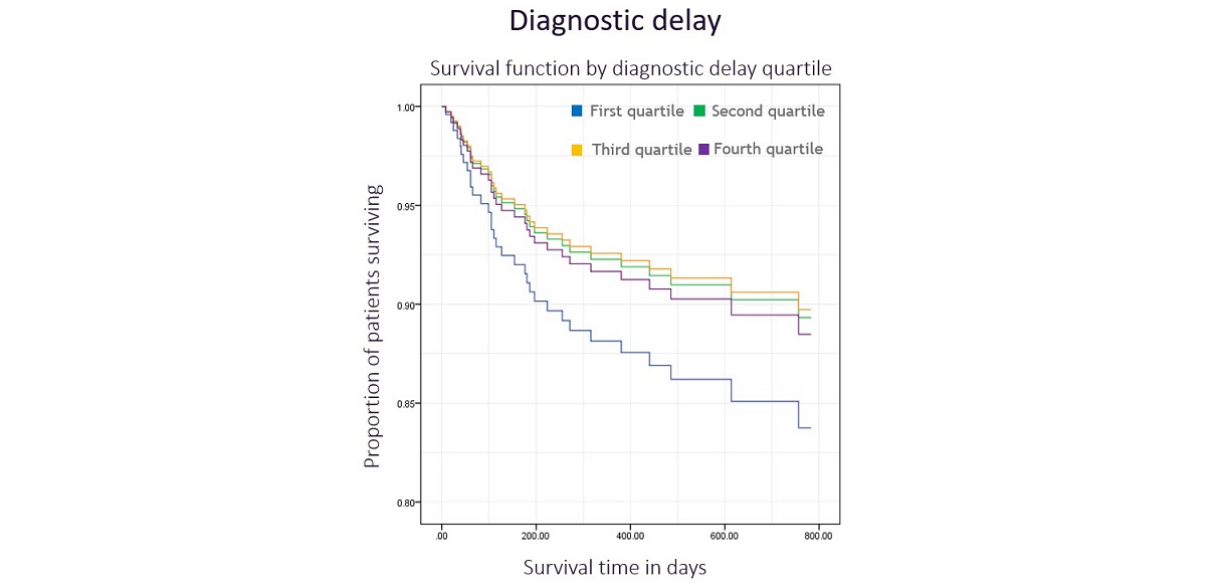
Figure 3. Kaplan-Meier plot illustrating the survival function by diagnostic delay quartile with time.